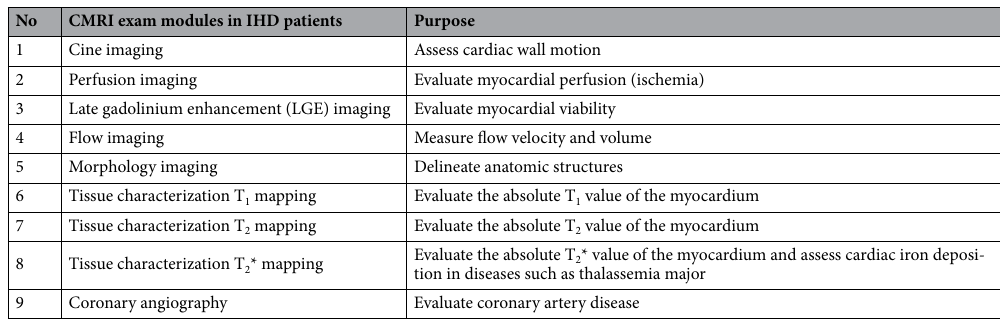
Table 2. Demonstrates purpose of CMRI exam modules in IHD patients.